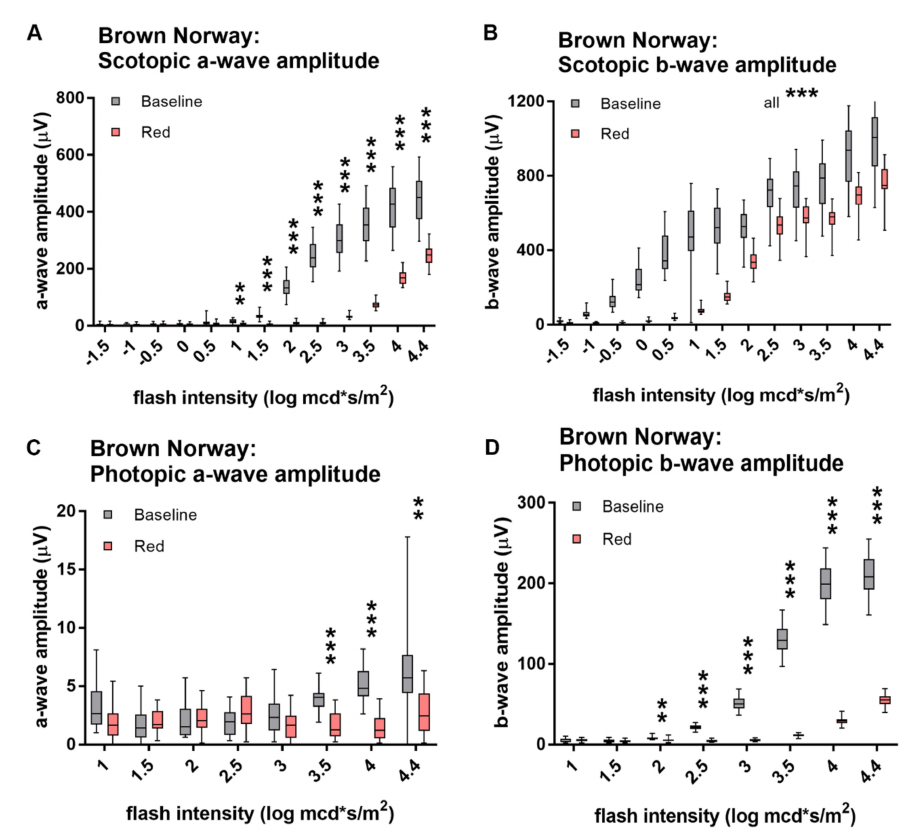
Figure 2. Scotopic ERG responses to white and red light. Scotopic a- ( A , C ) and b-wave ( B , D ) amplitudes of Brown Norway ( A,B ) and Wistar ( C,D ) rats stimulated with white and red light. Red-light-evoked amplitudes are significantly smaller than white-light-evoked ones, but di ff erences in b-wave amplitudes decrease with increasing light intensities. Statistics: t-test corrected with Holm-Sidak method for multiple comparisons. ** p ≤ 0.01, *** p ≤ 0.001.